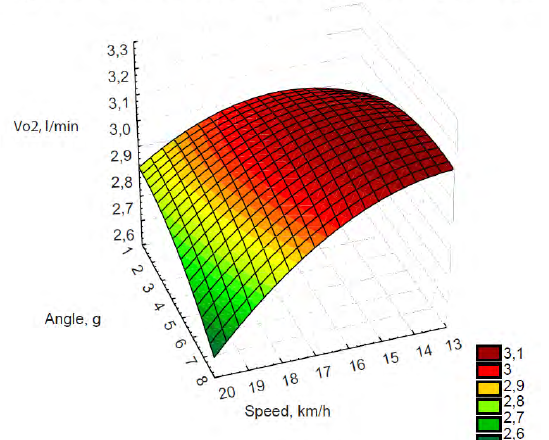
Fig.3. Model of interdependence of ski racers’ aerobic efficiency and speed of hills’ climbing, slope